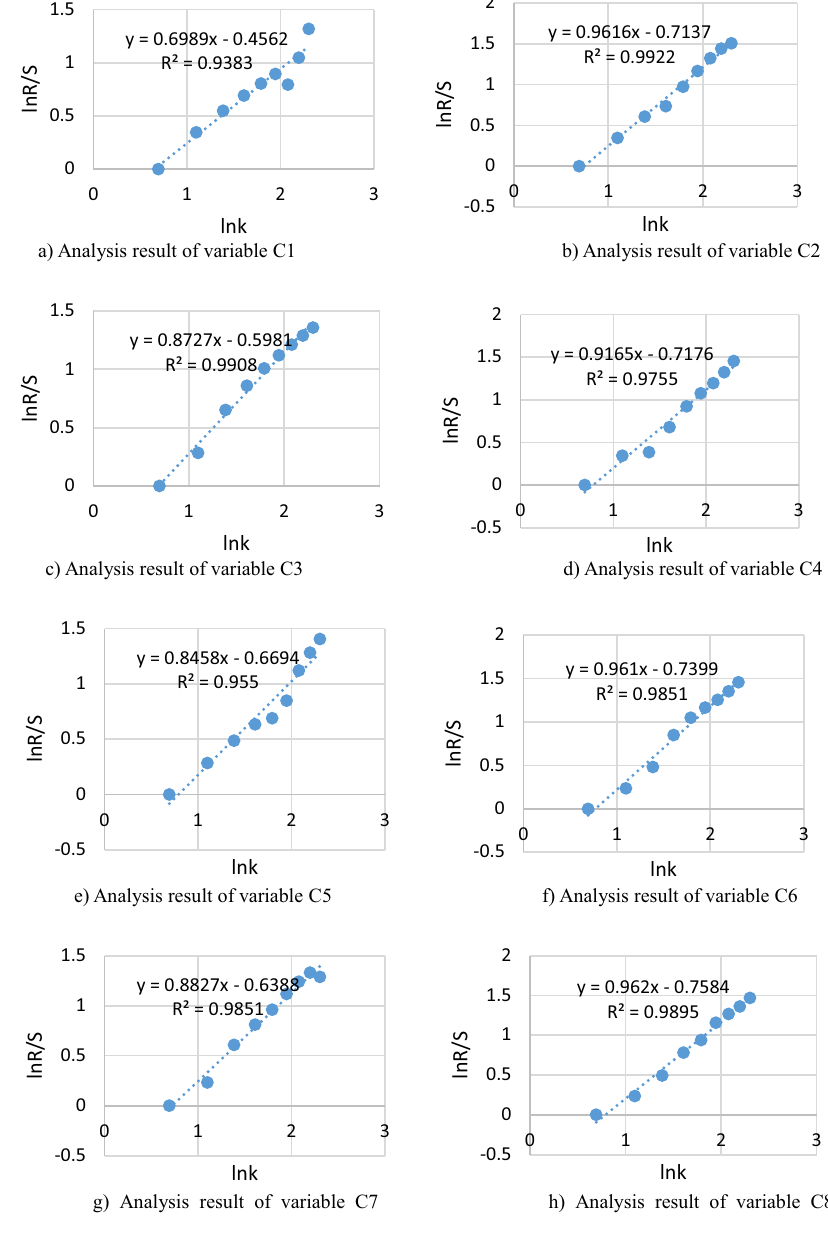
Figure 3. Results analysis in Anhui Province from 2011 to